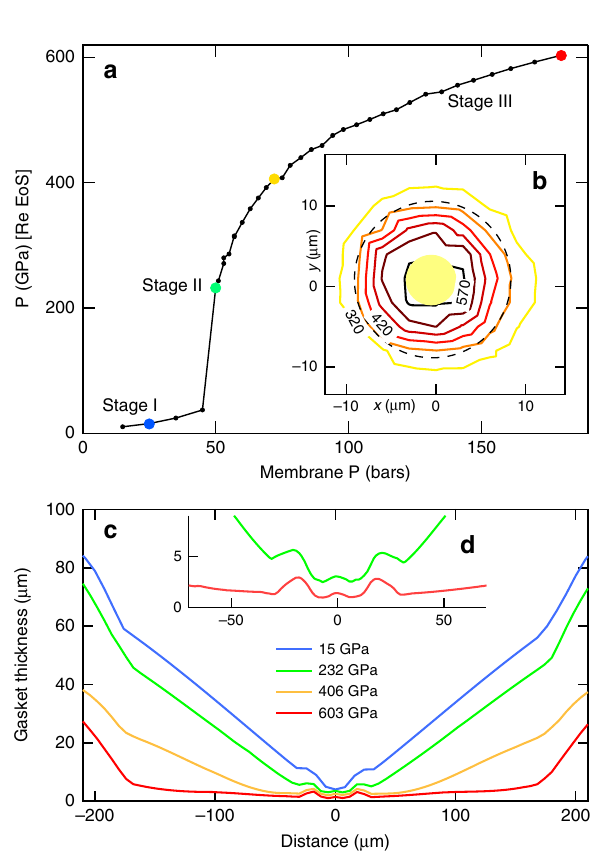
Fig. 2 Stress and strain measured in run 1. a Pressure at the center of the toroidal-DAC (t-DAC) measured using the XRD signal of rhenium gasket and rhenium equation of state 33 vs. membrane pressure. The membrane pressure is proportional to the load applied on the diamond table. The compression stages (I, II, and III) are discussed in the text. b Distribution of pressure measured every 3 μ m along a 13 × 13 points grid, with the same method. The pressure at the center of the t-DAC is 585 GPa. The dashed line indicates the limits of the central fl at and the yellow disc the extension of gold sample. c Thickness of the rhenium gasket measured using monochromatic X-ray ( λ = 0.3738 Å) absorption pro fi les. The pro fi les have been measured at various pressures indicated by dots with the same color in the sample P vs. membrane P curve in a . The red pro fi le corresponds to the data collected just before anvils breakdown. d Enlarged view of two pro fi les: the strain ( “ cupping ” ) of the central fl at can be clearly